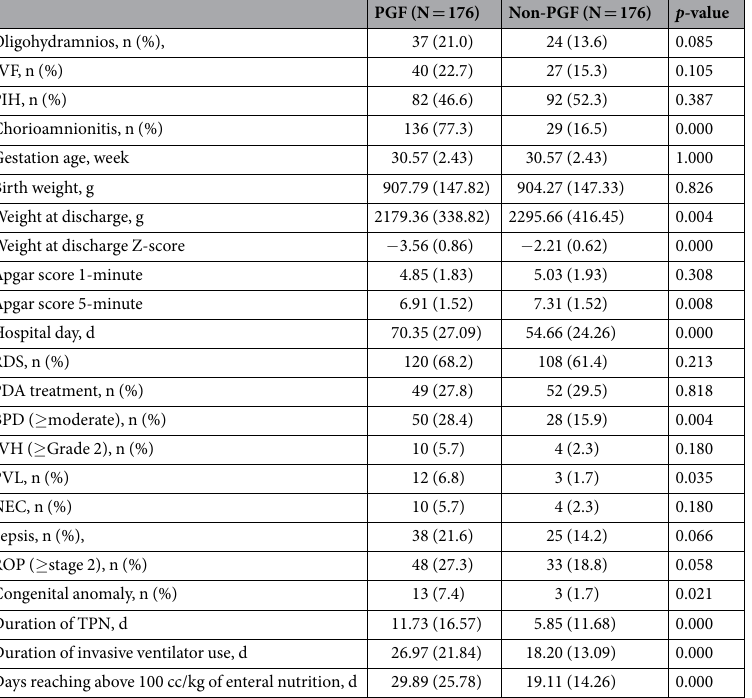
Table 5. Comparisons of relevant patient demographics and morbidity between the postnatal growth failure (PGF) and non-postnatal growth failure (Non-PGF) groups specifically among infants small for gestational age (SGA) after propensity score matching. Data are presented as numbers of patients (%) or mean (SD). PGF, postnatal growth failure; IVF, in vitro fertilization; PIH, pregnancy induced hypertension; RDS, respiratory distress syndrome; PDA, patent ductus arteriosus; BPD, bronchopulmonary dysplasia; IVH, intraventricular haemorrhage; PVL, periventricular leukomalacia; NEC, necrotizing enterocolitis; ROP, retinopathy of prematurity; TPN, total parenteral